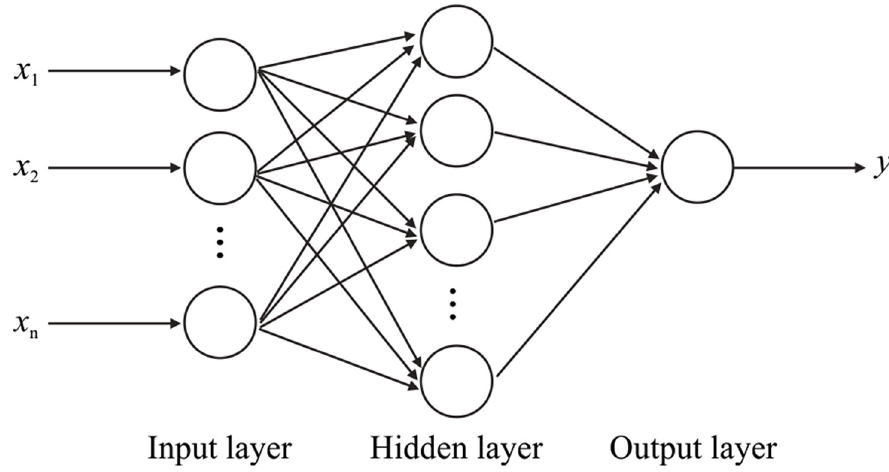
Figure 1. Multi Layer Perceptron, where x is the input and y is the output of a neuron. Each neuron receives as inputs ( x ) the results of its previous layer connection(s), calculates a weighted summation added with a certain bias (see Equation (1)) and then applies a nonlinear transformation to finally compute its activation output ( y ). This latter output is passed onto the next connected layer neurons as their